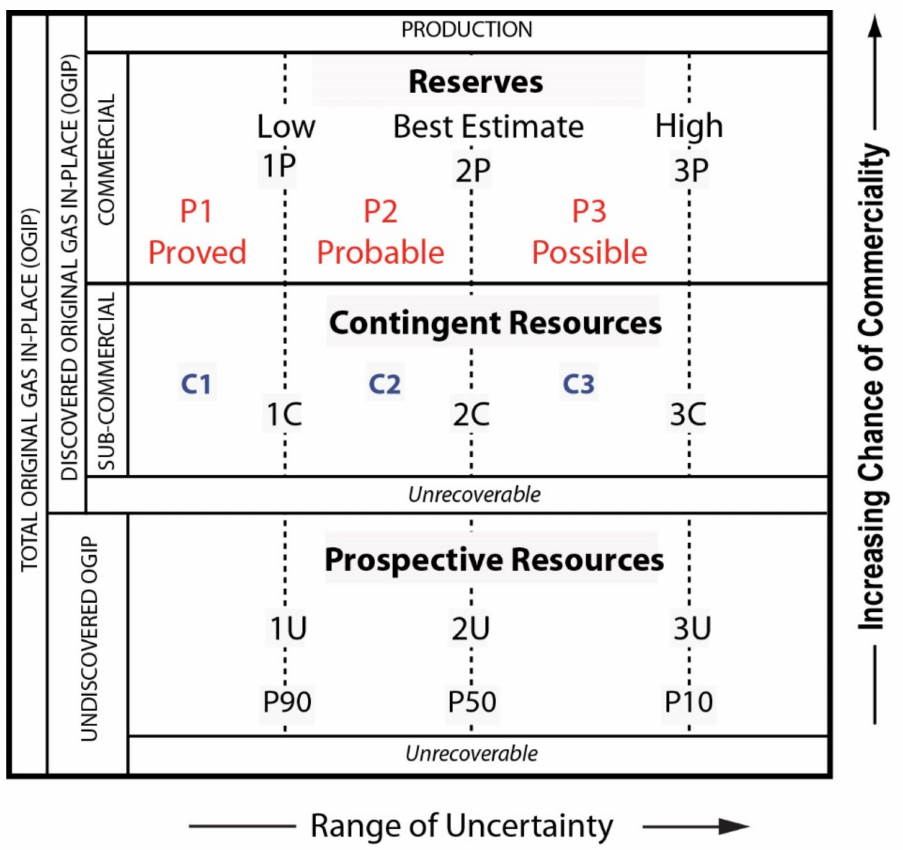
Figure 4. Resource classification framework as defined by the Petroleum Resource Management System (PRMS)